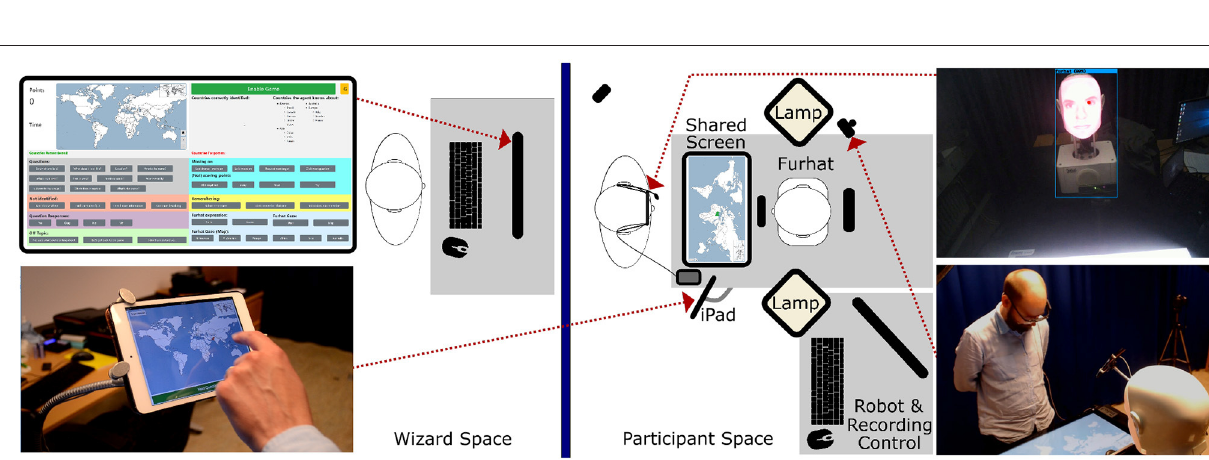
FIGURE 2 | Schematics of the experimental setup during the interaction session, including the operator interface (top left) , the Tutor’s screen on the iPad (bottom left) , the eye-tracker recording from the participant’s point of view with indicated center of attention and detected objects (top right) , and recording from one of the RGB cameras (bottom right)